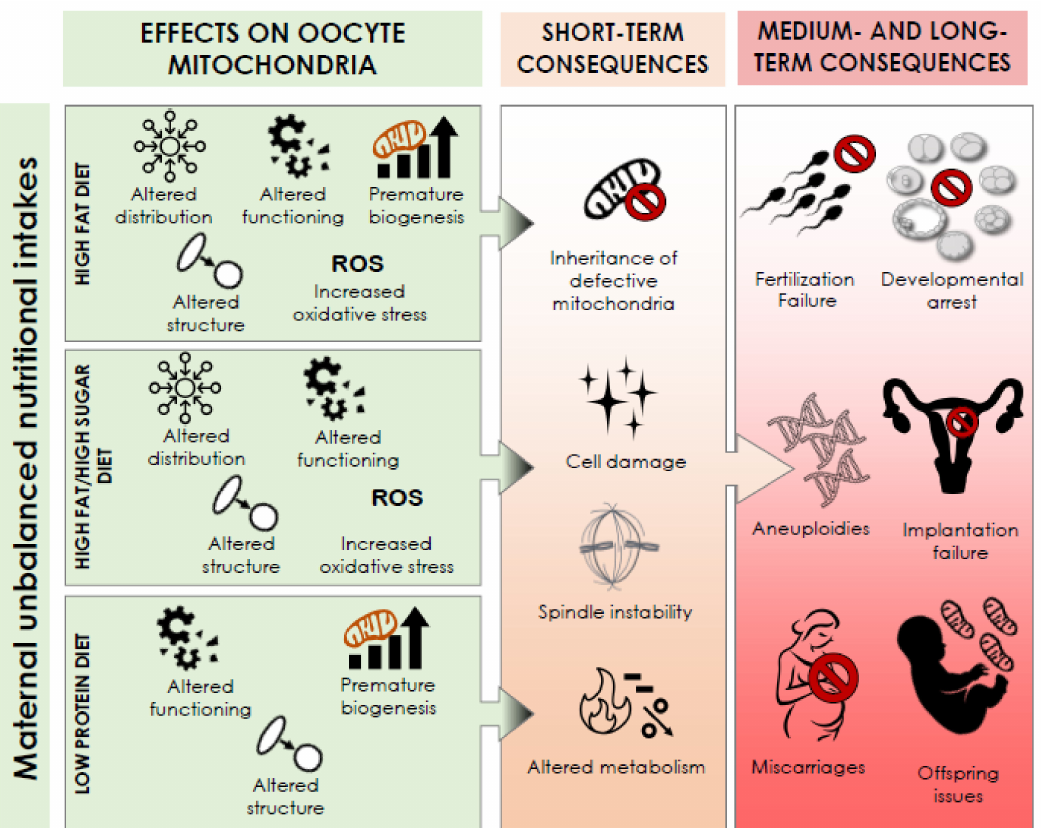
Figure 1. Summary of the effects of maternal unbalanced nutritional intake on oocyte mitochondria and their putative short-, medium-, and long-term